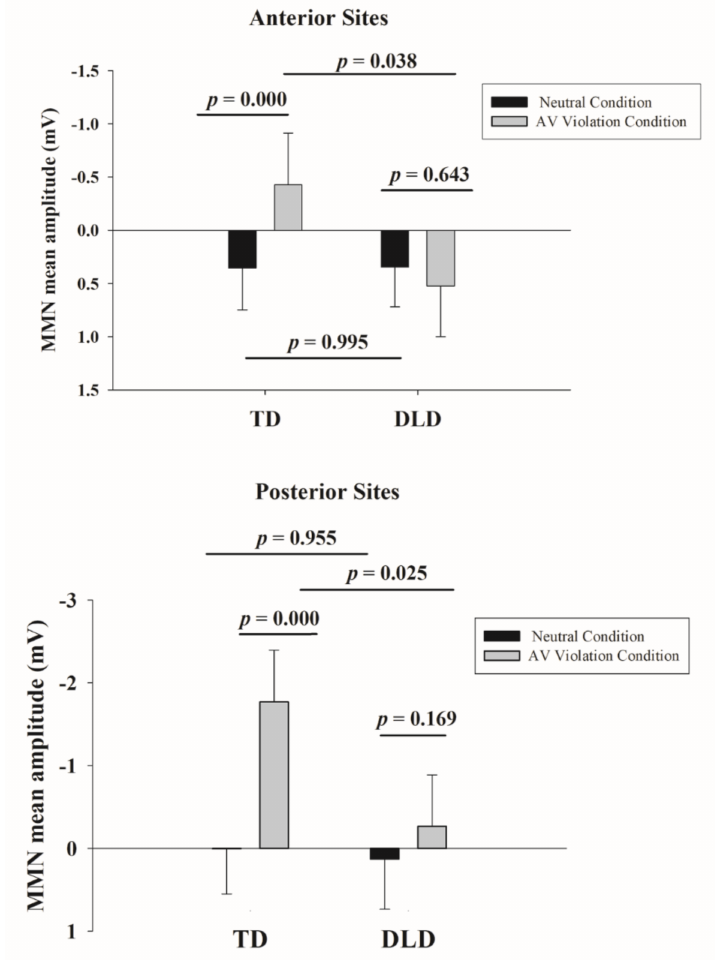
Figure 6. Mismatch negativity (MMN) mean amplitude. Table 7. Anterior MMN model simple effects for the group-by-condition interaction. b p